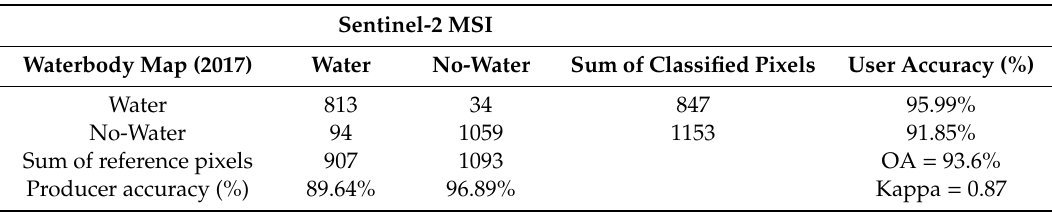
Table 1. The confusion matrix and accuracy evaluation for the maximum surface water map of the Huai River Basin based on a visual inspection of Sentinel-2 MSI